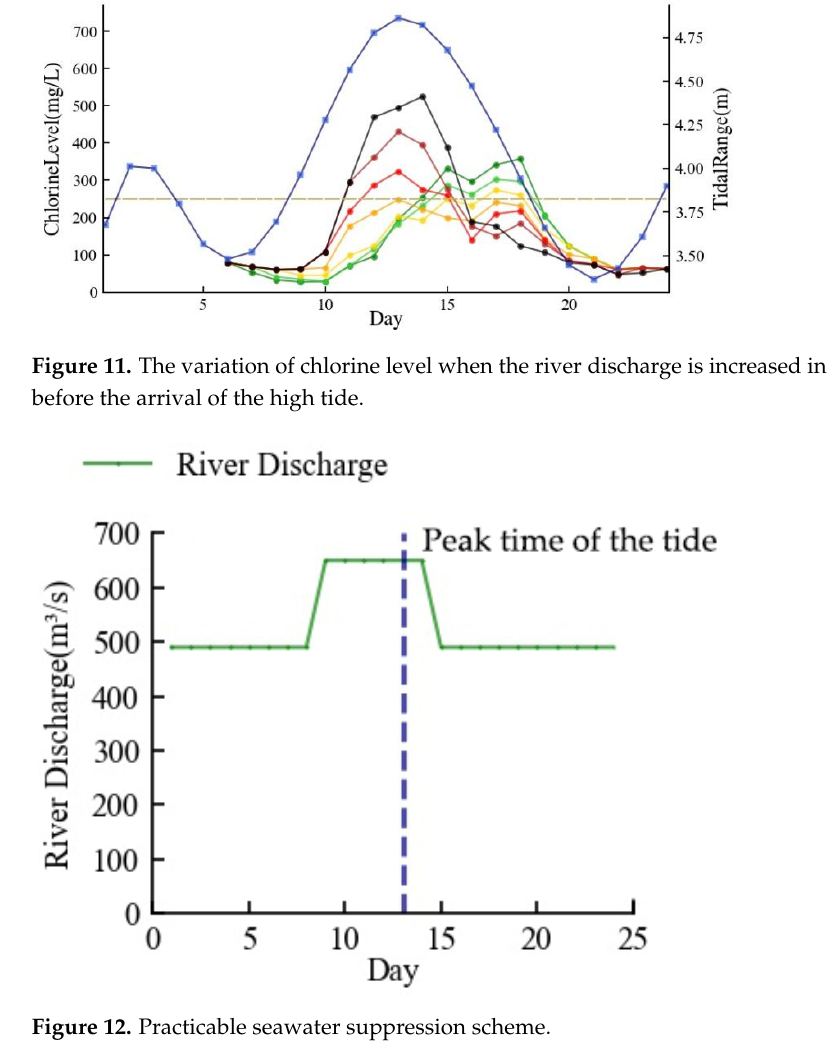
Figure 12. Practicable seawater suppression scheme.